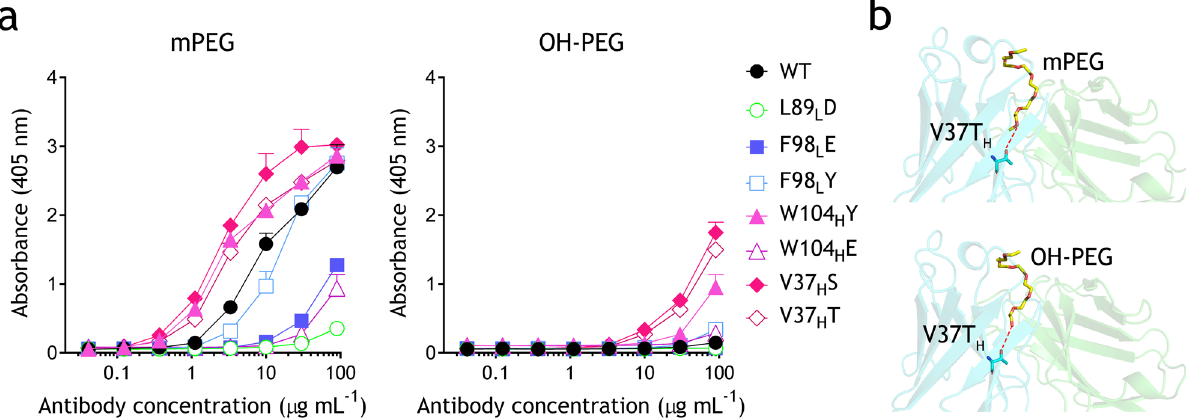
Fig. 4 Speci fi city of h15-2b Fab variants against methoxy- and hydroxyl-PEG molecules. a Microplate wells coated with mPEG 5K -NH 2 and OH-PEG 5K - NH 2 were incubated with graded concentrations of parental h15-2b or relevant variants corresponding to methoxy group interacting residues. After 1 h, the wells were washed, and antibody binding was determined by adding HRP-conjugated goat anti-human F(ab ’ ) 2 fragment speci fi c antibodies, followed by ABTS substrate. The results show the mean absorbance values (405 nm) ± standard deviation ( n = 3). The data are representative of three independent experiments. b Simulated binding models of mPEG or OH-PEG (yellow sticks) interacting with the V37 H T variant. Hydrogen bonds are indicated by red